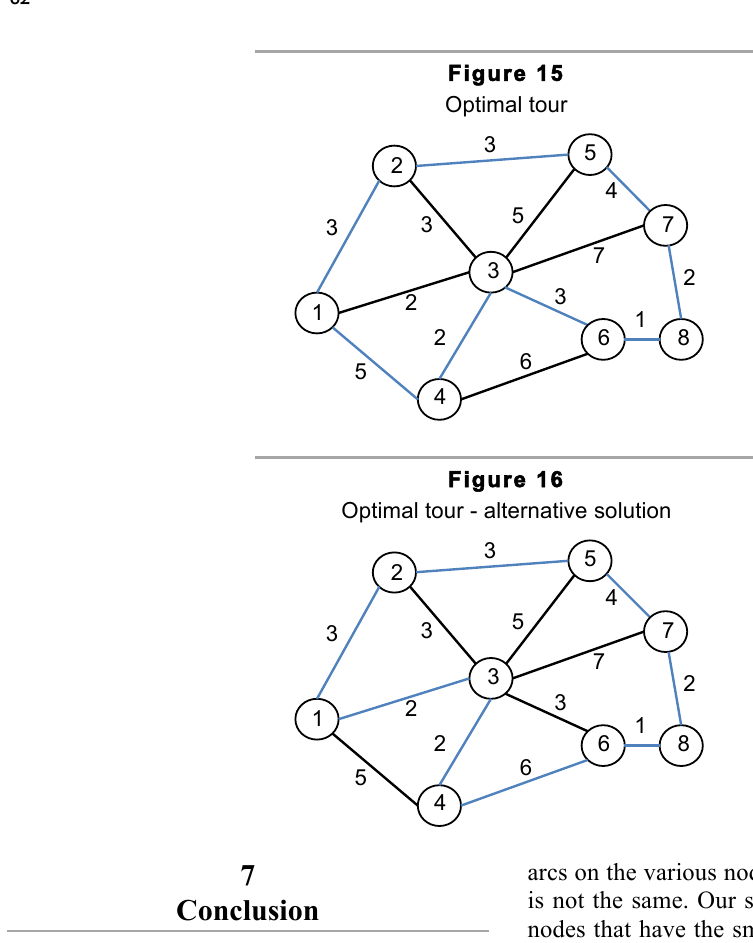
Optimal tour - alternative